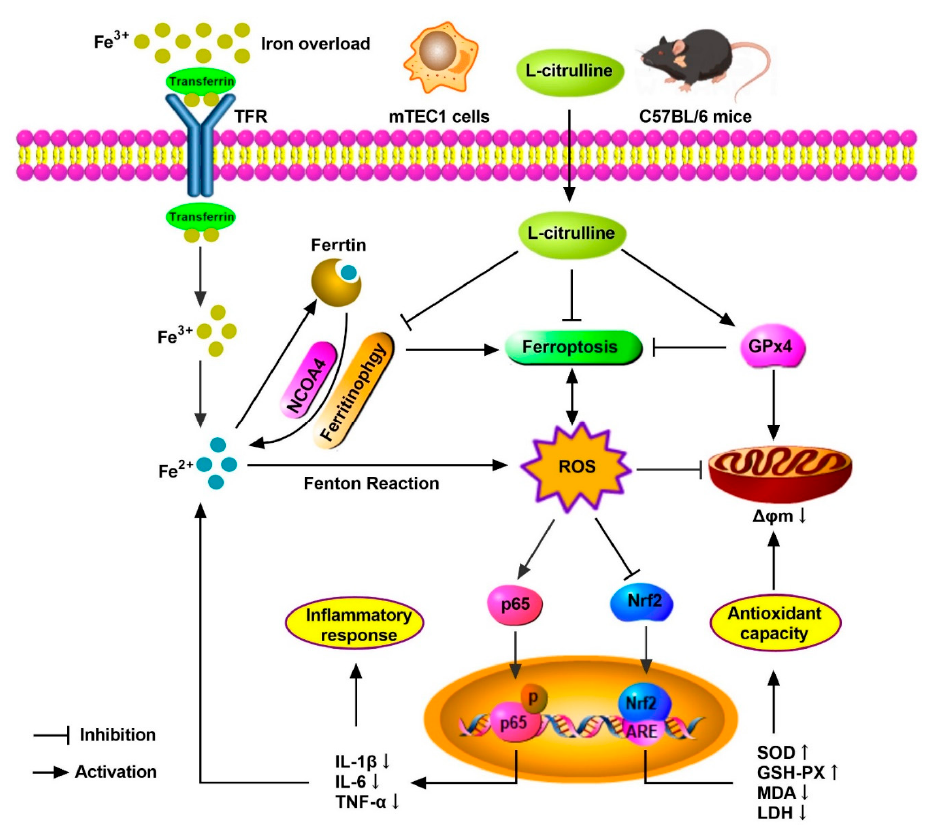
Figure 10. The schematic illustration of underlying mechanism of L-cit alleviating oxidative damage and immune dysfunction. As a result, L-cit alleviates thymus histological damage, reduces the iron deposition, improves antioxidative capacity, and restrains NF- κ B pathway in the mouse thymus and mTEC1 cells. NCOA4-mediated ferritinophagy and ferroptosis were attenuated. L-cit might target ferritinophagy-mediated ferroptosis to decrease iron deposition and exert antioxidation and anti-inflammation response, which could be a therapeutic strategy against iron overload-induced oxidative damage and immune dysfunction.